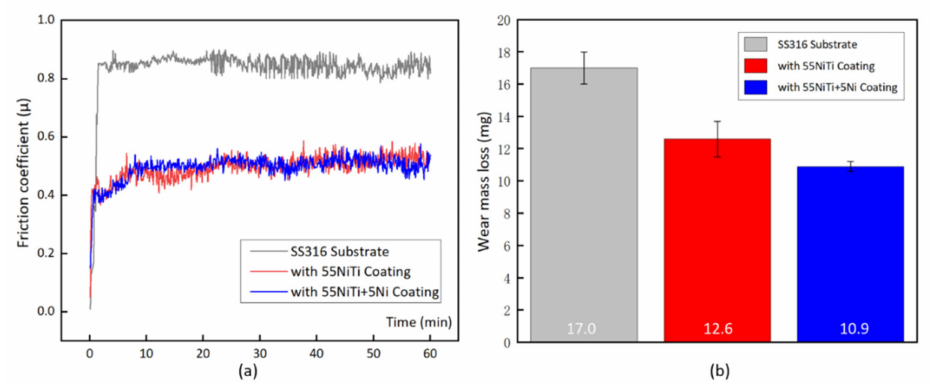
Figure 14. Wear resistance of cladding layers: ( a ) friction coefficient ( b ) wear mass